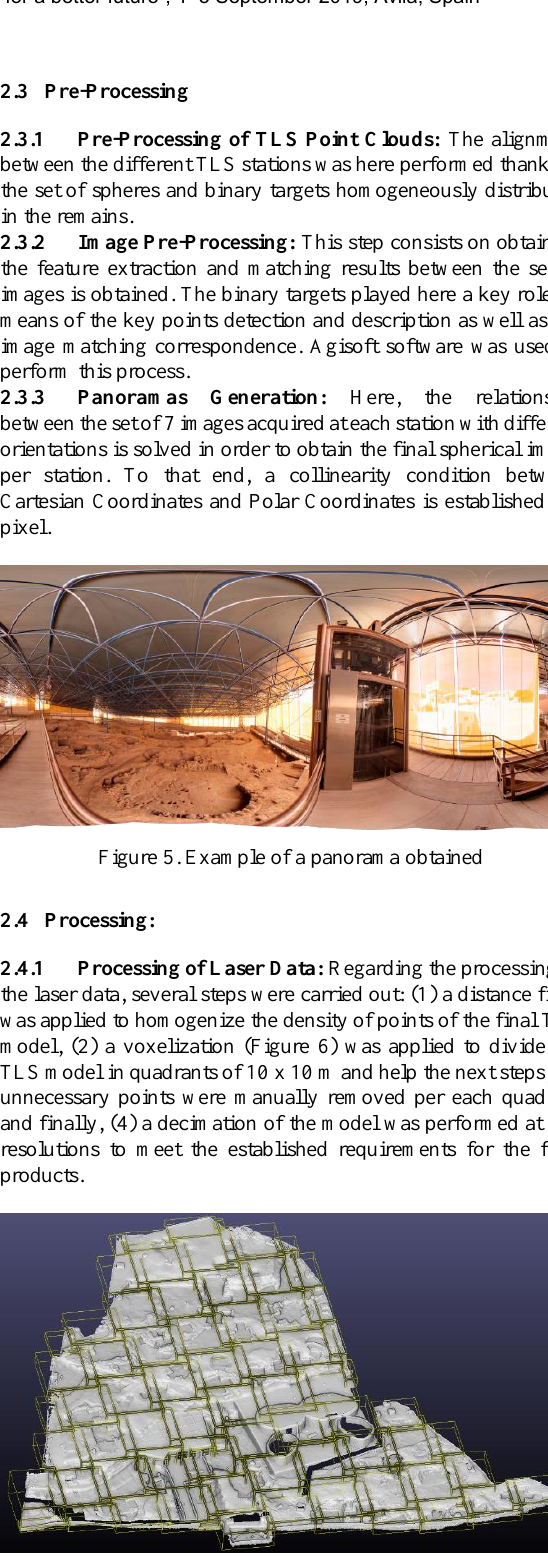
Figure 6. Voxelization applied to the laser scanning 3D